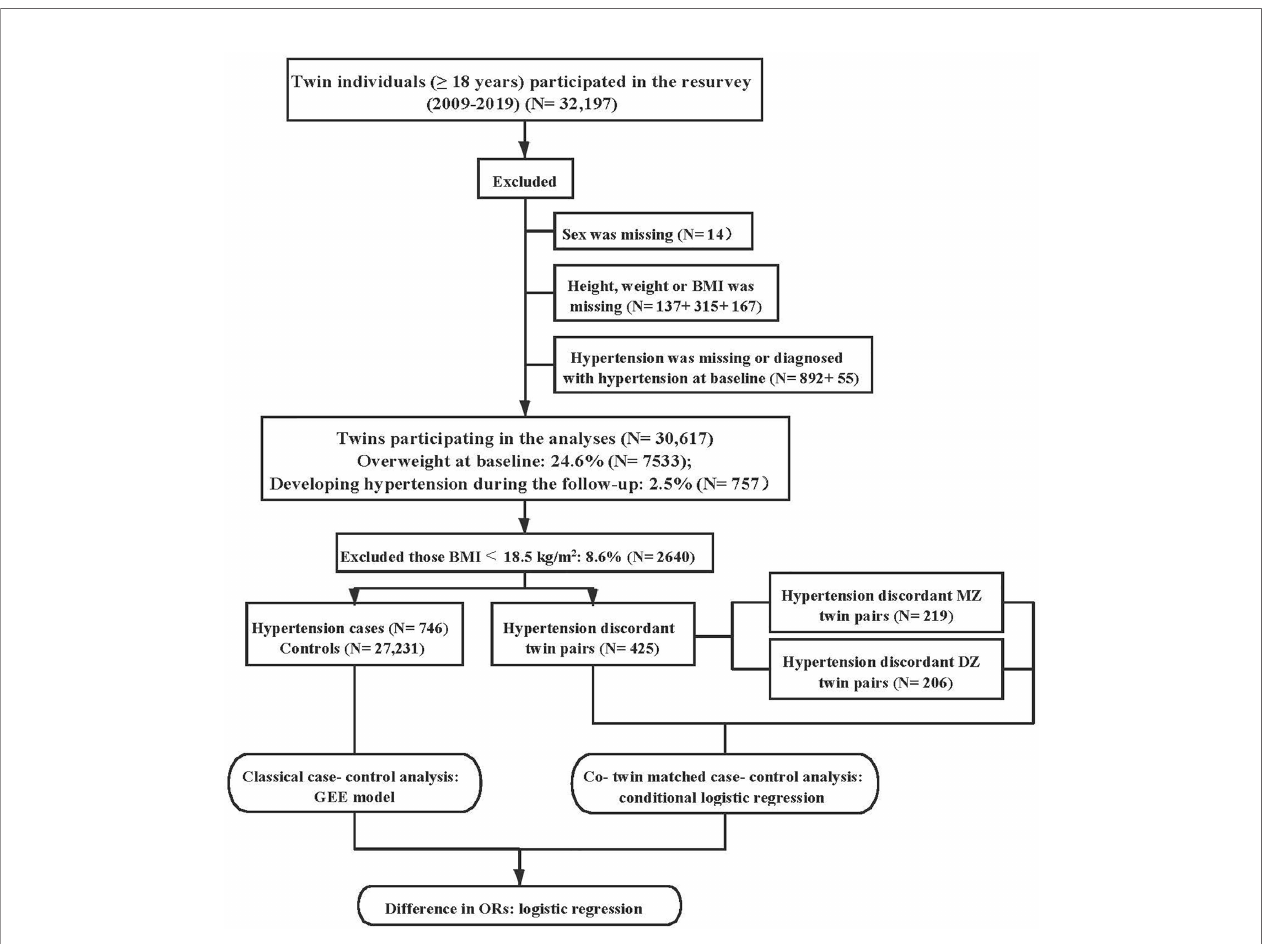
FIGURE 1 | Flow chart of the study population and data analysis. BMI, body mass index; MZ, monozygotic; DZ, dizygotic; GEE, generalized estimating equation; OR, odds